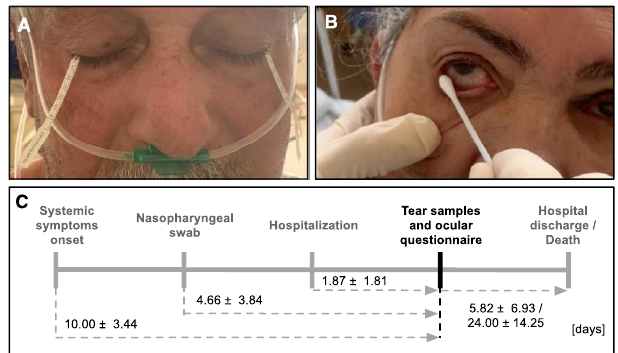
Figure 1. Samples were collected using Schirmer strips and conjunctival swab after hospitalization, and patients were followed until discharge or death. ( A ) Collection of Schirmer strips. ( B ) Collection of conjunctival swab. ( C ) Overview of timepoints of sample collection. Numbers indicate mean days and standard deviation between the indicated event and tear sample collection.